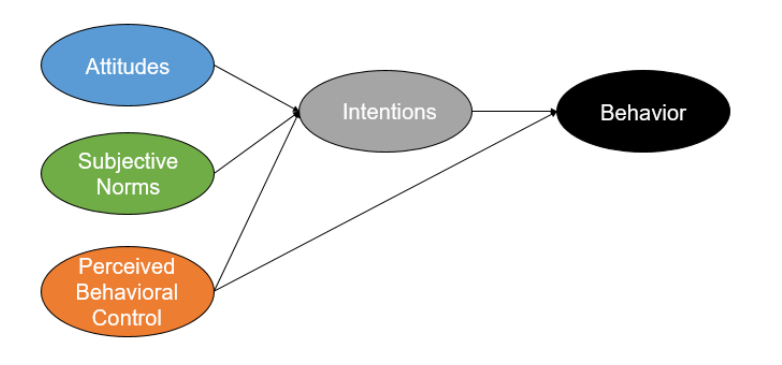
Figure 2: A visual presentation depicting the theory of planned behaviour; Source: Worthington,